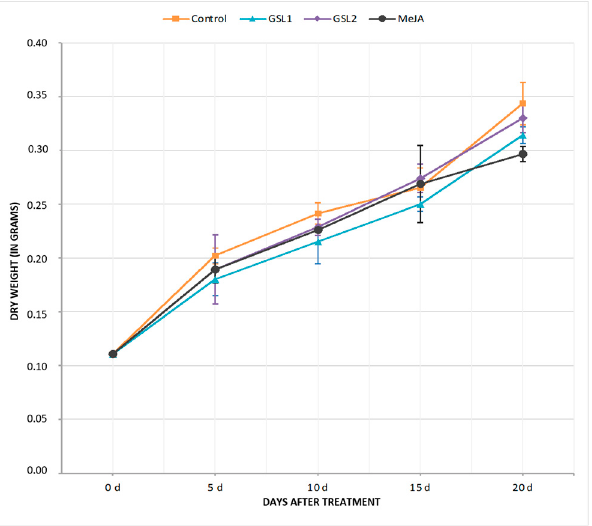
Figure 1. Photographs of A. malaccensis callus 20 days after treatment with elicitors. Callus grew in the presence of elicitor derived from mycelium of F. solani strain GSL1 ( A ), strain GSL2 ( B ), and MeJA ( C ) had similar brownish appearances compared to the control untreated callus ( D ).